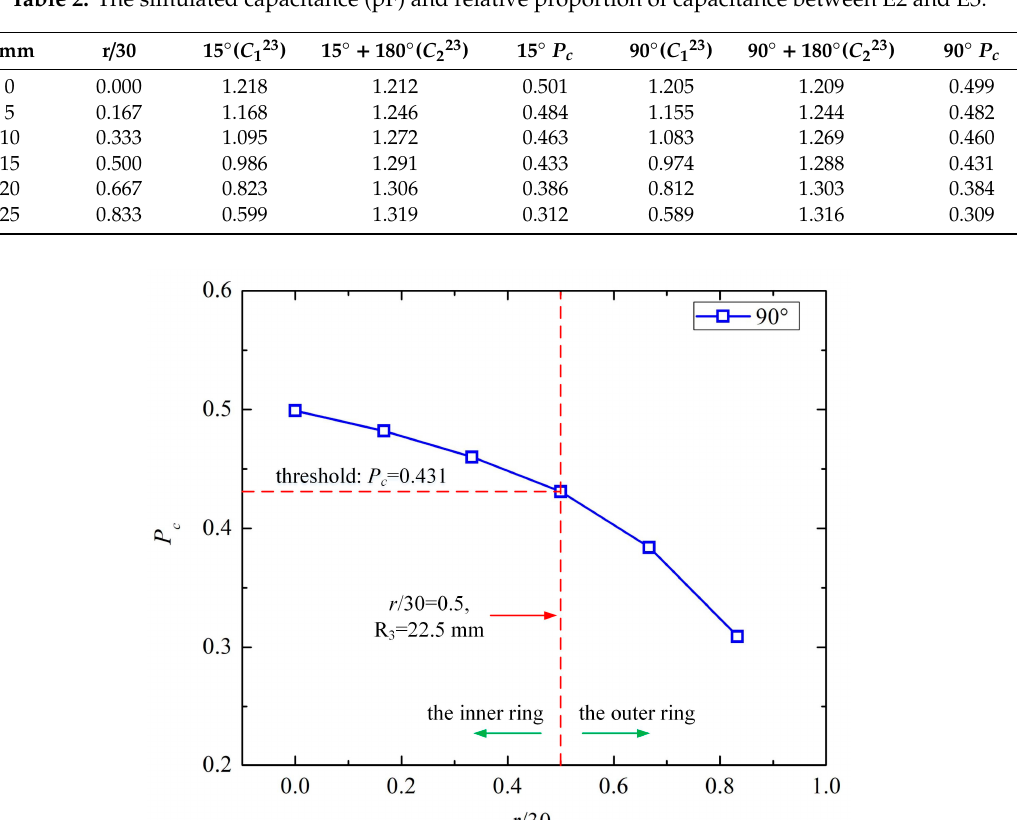
Figure 8. The trend of the relative proportion of capacitance and center distance percentage.